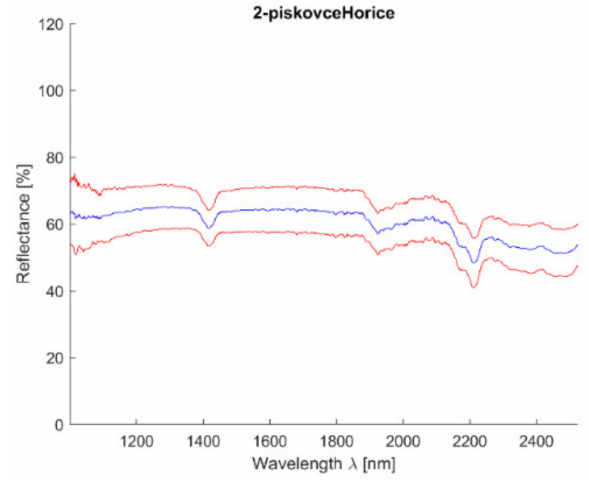
Figure 8. Hoˇrice sandstone—mean value (blue) and 2,5*standard deviation (red). Minimum standard deviation: 1.32% (for λ = 1816.356 nm) Maximum standard deviation: 2.99% (for λ = 1001.238 nm) Mean standard deviation: 1.69%